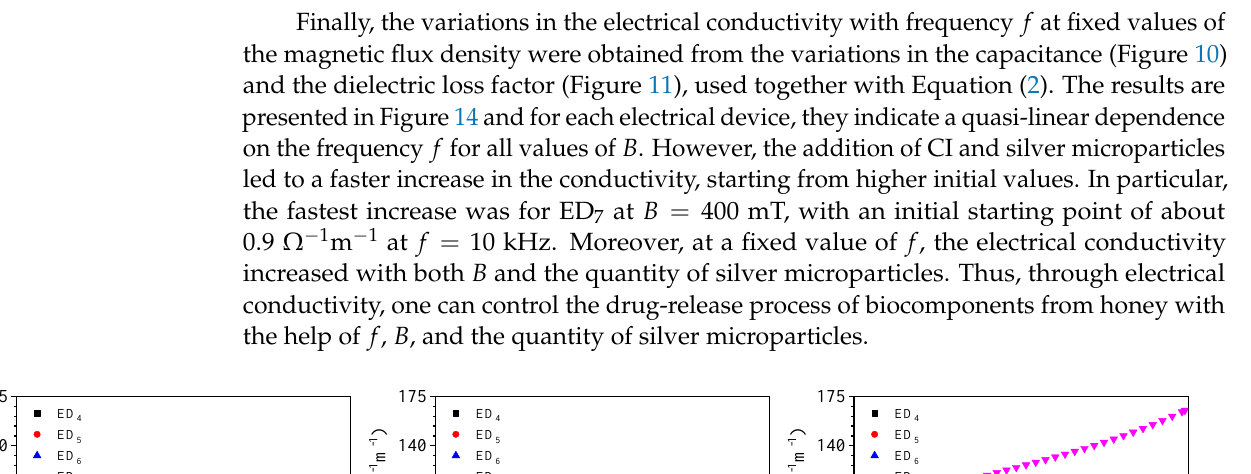
Figure 13. Variations in time constant τ with the frequency f of a sinusoidal electric field at discrete values of the magnetic flux density B . ( a ) B = 0 mT. ( b ) B = 200 mT. ( c ) B = 400 mT.